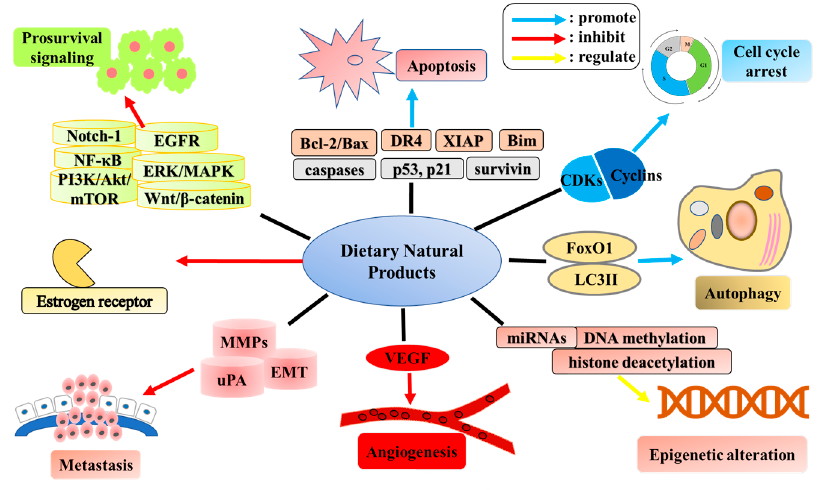
Figure 4. Mechanisms involved in the anti-breast cancer action of dietary natural products. Table 2. The in vitro and in vivo effects of dietary natural products against breast cancer.